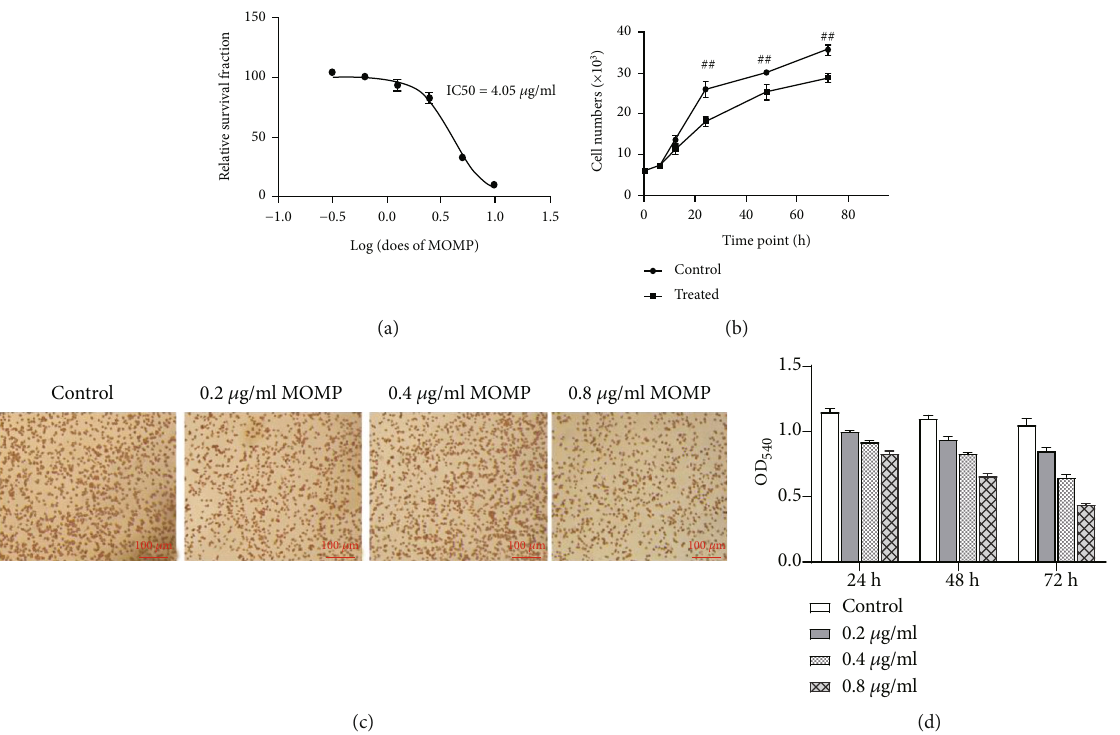
Figure 1: MOMP inhibits the proliferation and phagocytic activity of RAW264.7. (a) A dose-response study of MOMP indicated IC50 as 4.05 μ g/ml. The curve was fi tted using relative survival fraction of six working concentrations (10, 5, 2.5, 1.25, 0.625, and 0.3125 μ g/ml). (b) The proliferating capacity of RAW 264.7 upon the treatment of MOMP. Statistical analysis by one-way ANOVA, ## P < 0 : 01 . Error bars = 95 % con fi dence intervals. (c) The cytological phagocytosis of RAW 264.7 by neutral red uptake assay at 24h in the four groups (control; cells treated with 0.2 μ g/ml MOMP; cells treated with 0.4 μ g/ml MOMP; and cells treated with 0.8 μ g/ml MOMP) (original magni fi cation: 200x, scale bar = 100 μ m ), P < 0 : 05 indicated signi fi cant di ff erences in neutral red uptake of cells between control and treated groups. (d) Semiquantitative analysis of the phagocytosis of RAW 264.7. The signi fi cant di ff erences were marked by the alphabetic notation (a, b, c, and d). In each same time point of di ff erent concentration treatment groups, if any two histograms with the same marking letter represented there have no signi fi cant di ff erence between two concentration treatments, any two histograms without the same marking letter represented there have a signi fi cant di ff